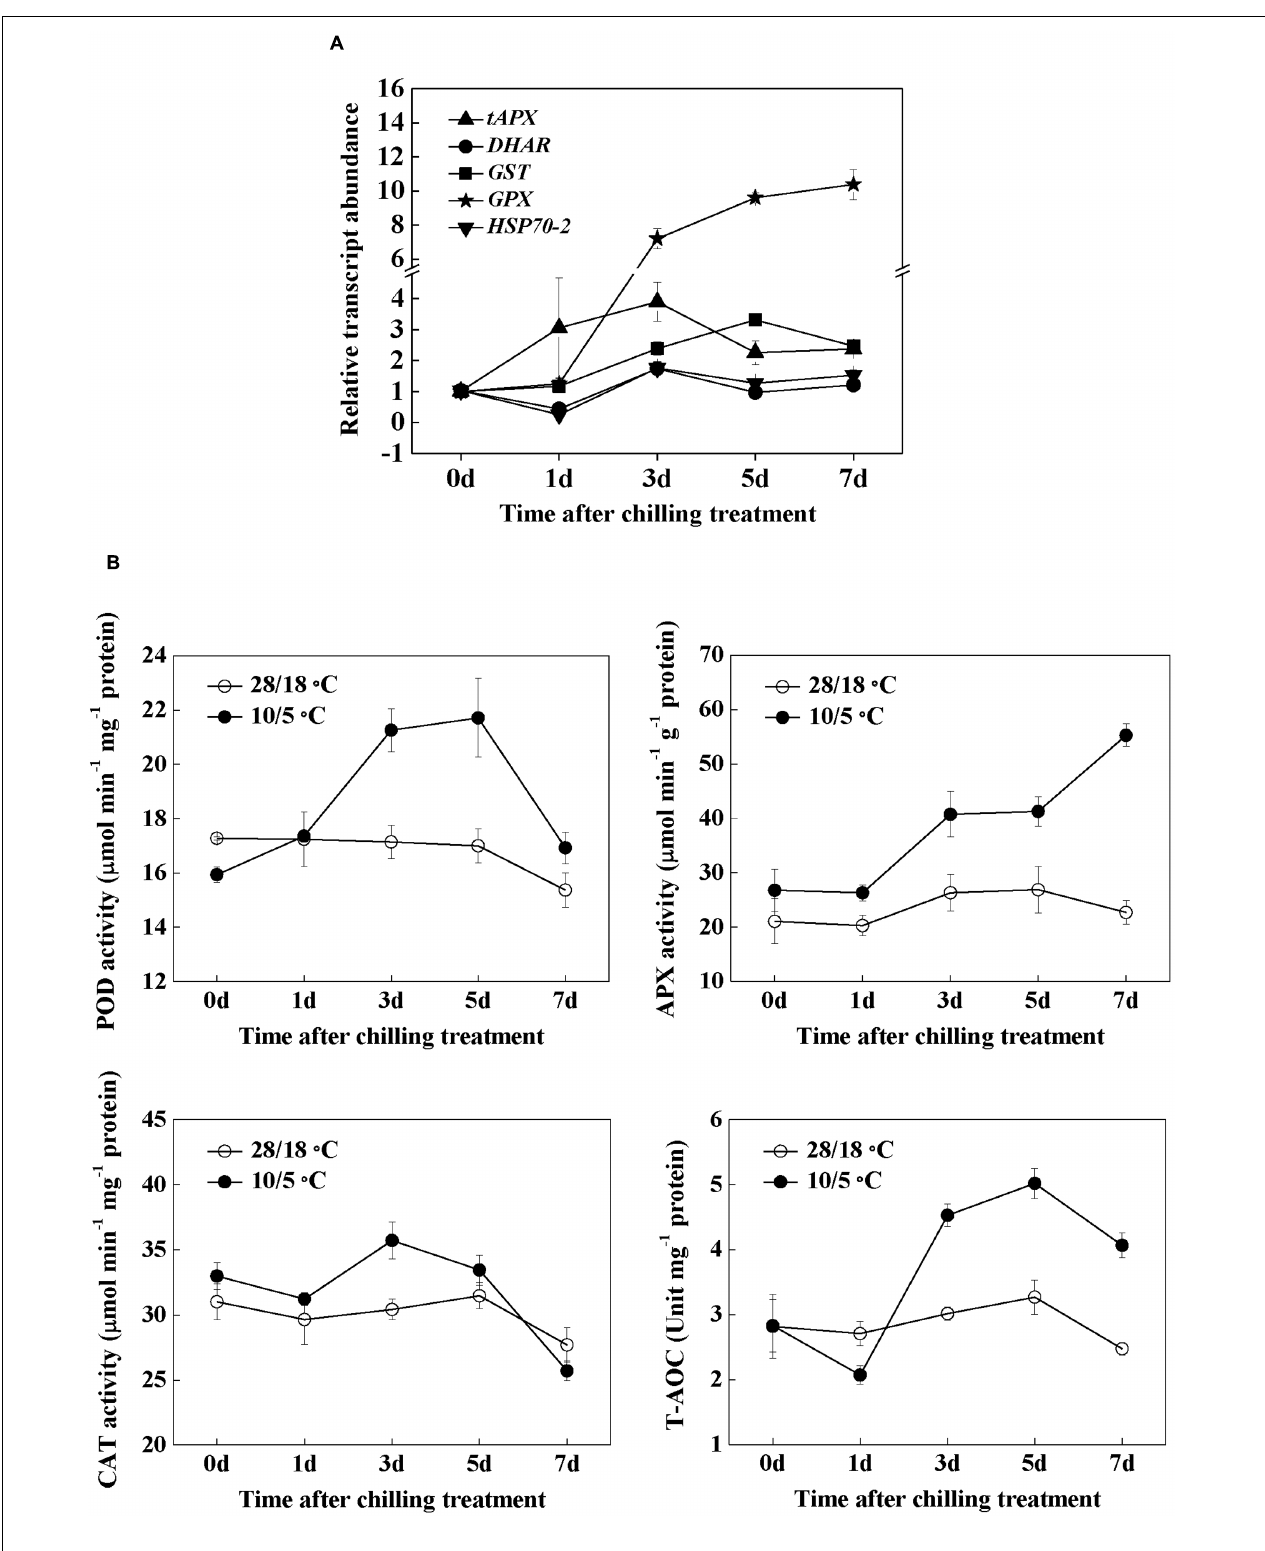
FIGURE 7 | The time-course response in gene expression of antioxidant genes (A) and activities of antioxidant enzymes (B) to chilling stress in watermelon. Leaf samples were collected at the indicated times. The data are the means of four replicates with SEs.